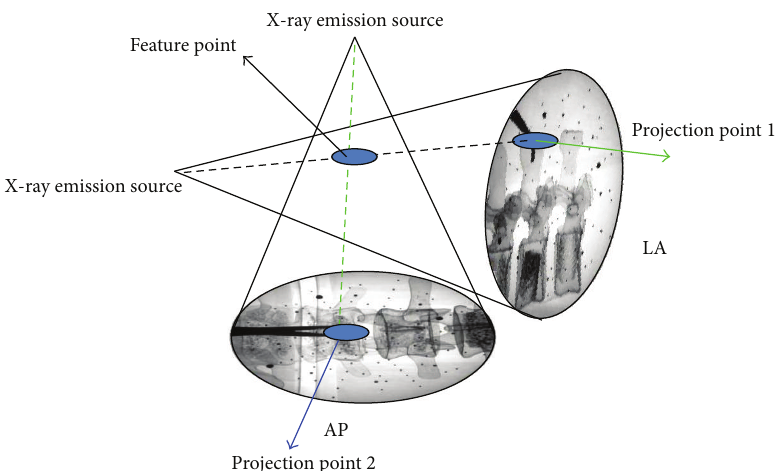
Figure 3: The spatial position of the feature point determined by its projection points.